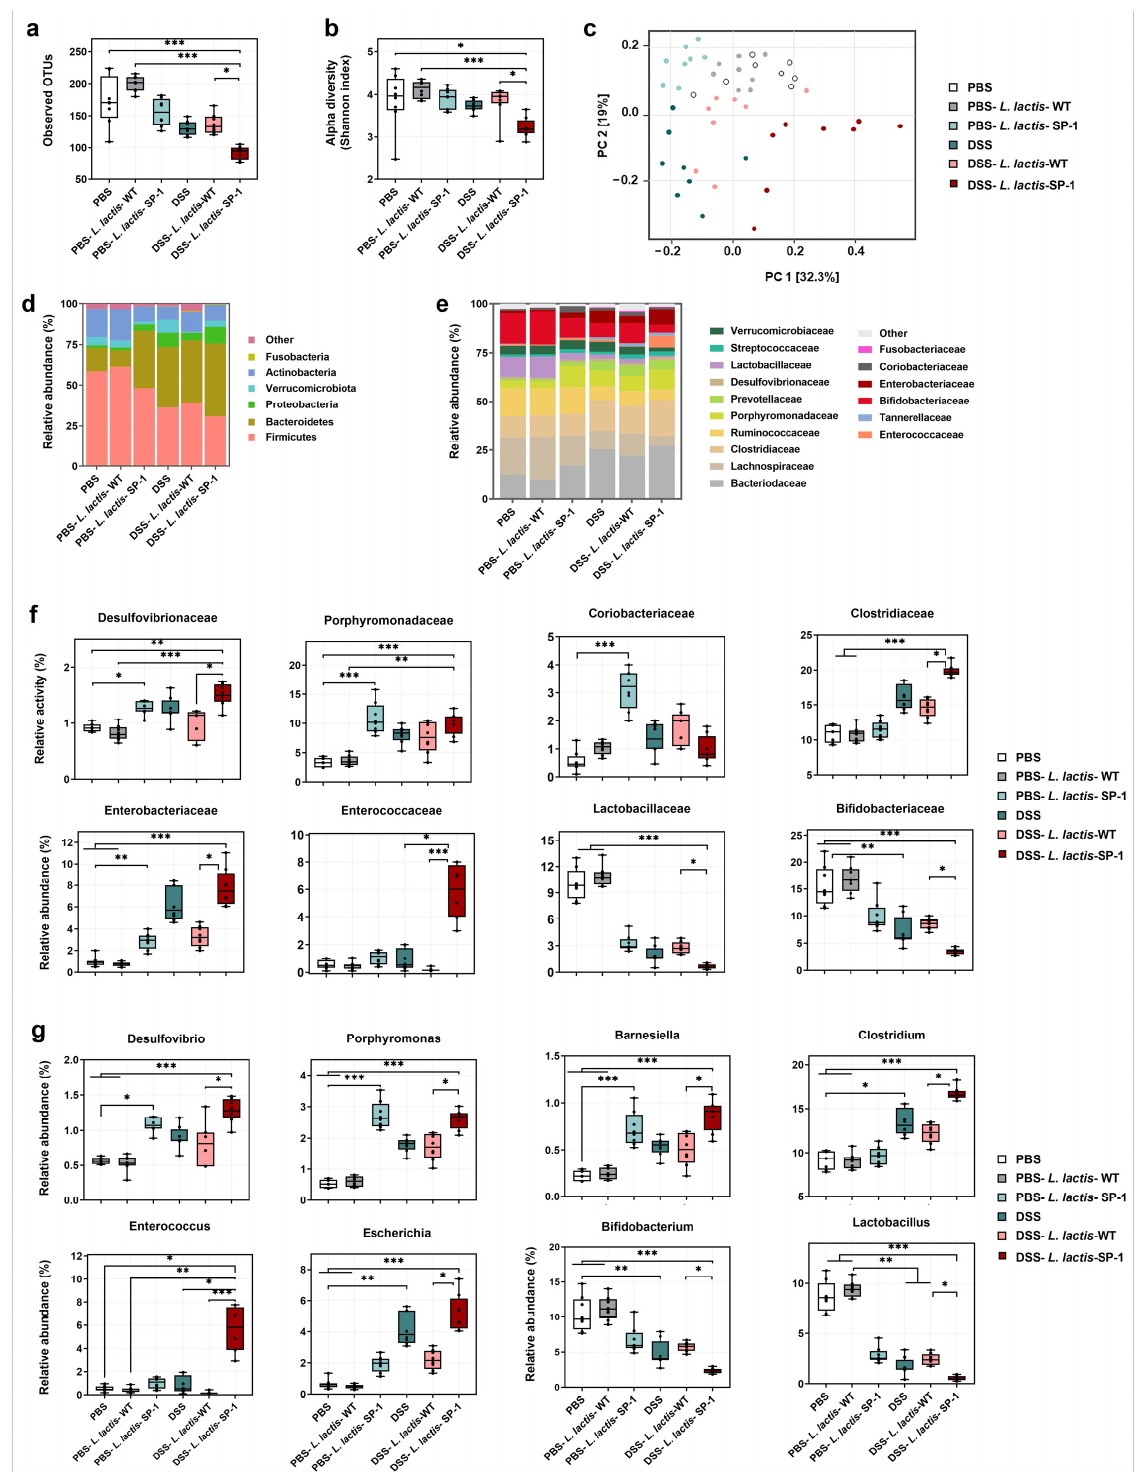
Figure 6. SP-1 administration alters the composition of gut microbiota. ( a ) Estimation of microbial community observed OTU richness and ( b ) α -diversity (Shannon index). ( c ) PCoA plot illustrating the gut microbiota β -diversity. Each point represents each mouse based on a subsample of 12803 OTUs. ( d – e ) Relative abundance of gut microbiota. Phylum- and family-level taxonomy are presented as a percentage of total sequences. ( f ) Microbial families with significantly different abundance between studied groups. ( g ) Microbial genera with significantly different abundance between studied groups. Data are presented as mean ± SEM. Data were analyzed by the Kruskal–Wallis test followed by Dunn’s test. * p < 0.05; ** p < 0.01 and *** p <